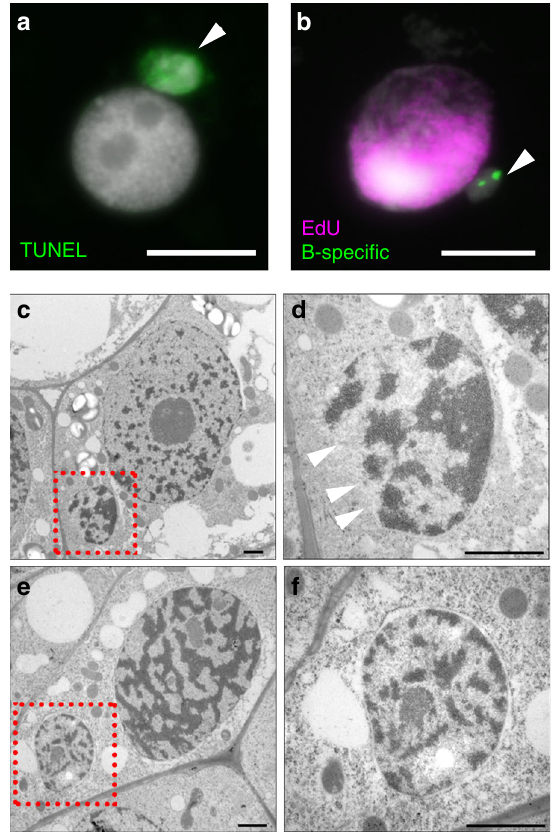
Fig. 3 Chromatin structure and replication differs between micronuclei and primary nuclei. a Micronuclei chromatin assessed by the TUNEL assay. 9% ( n = 184) of analyzed micronuclei (arrowed) were TUNEL positive (in green). Scale bar, 10 µ m. b None of the micronuclei ( n = 120) incorporated EdU, despite normal DNA replication of the primary nuclei. EdU is shown in purple, the B-speci fi c FISH probe AesTR-183 in green. Scale bar, 10 µ m. c – f Electron micrographs of ultra-thin tissue sections of developing + B embryos. Micronuclei ( n = 30) are marked by red squares and are further enlarged. c , d A micronucleus with a disrupted membrane (arrowed, was observed in 20% of the cases) and an increased chromatin density (43% of micronuclei showed dense chromatin) in comparison to the corresponding nucleus. Scale bar, 1 µ m. e , f Micronucleus surrounded by an intact double membrane and with a considerable amount of euchromatin. Scale bar, 1 µ